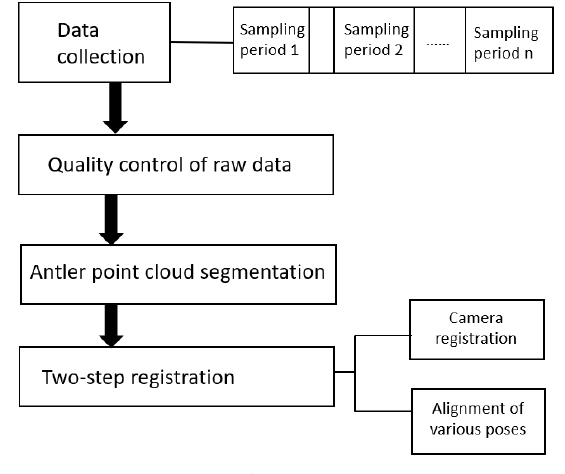
Figure 5. Flow chart of antler point cloud